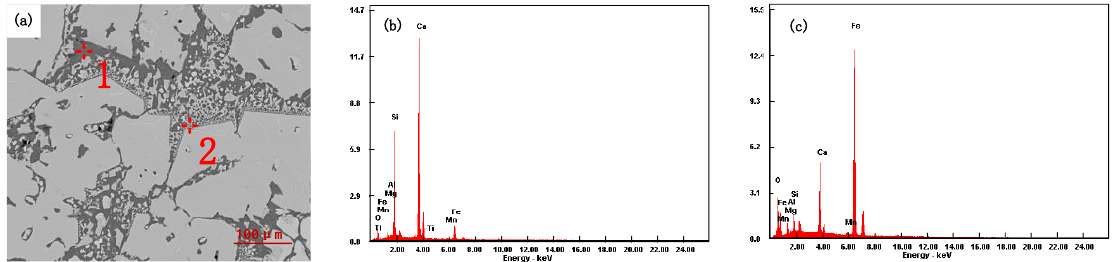
Figure 14. Scheme 2 SEM and EDS diagram of sinter: ( a ) Scheme 2 sinter, ( b ) 1, ( c ) 2.